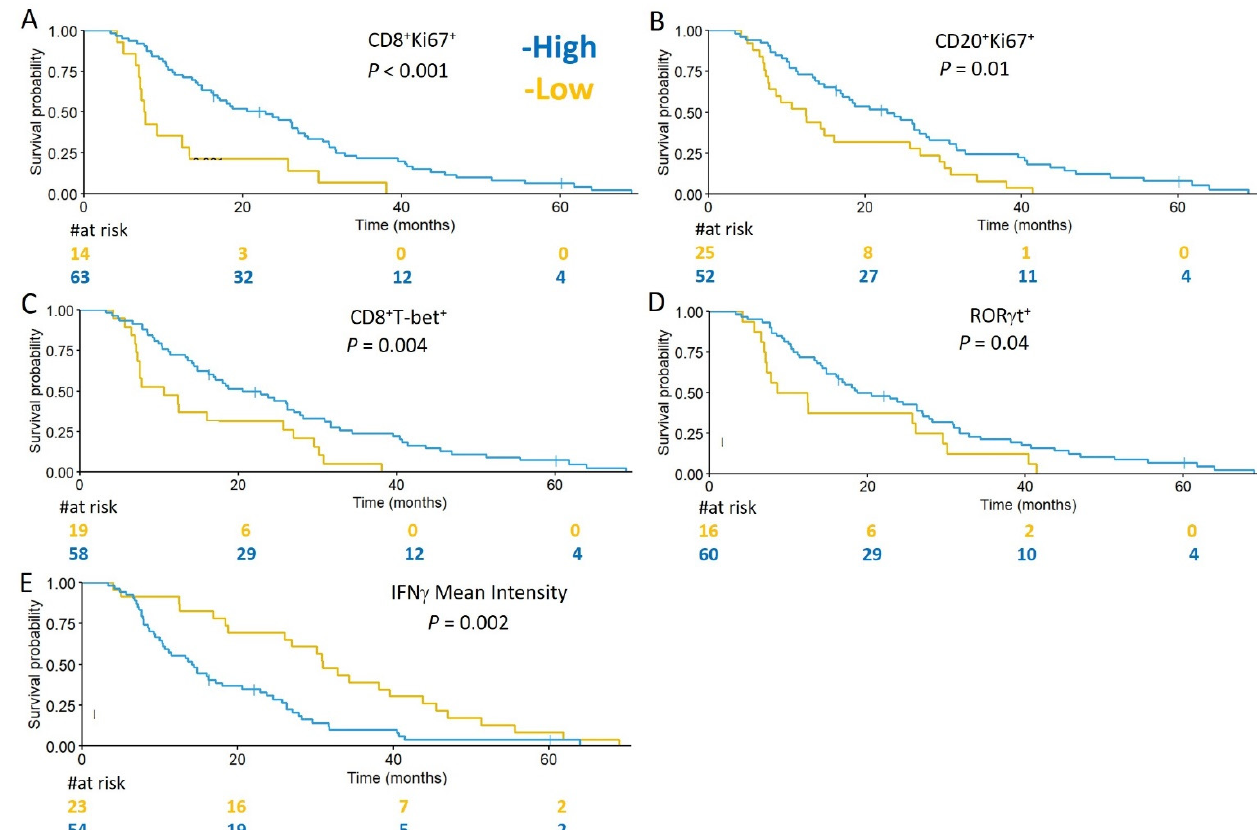
Figure 3. Markers of immune activity are associated with OS in GBM. Kaplan–Meier curves for the indicated immune markers, dichotomized into high (blue) and low (yellow), are shown in ( A – E ). Prolonged OS is associated with tumors containing high densities of: CD8 + Ki67 + cell infiltrates high (22.8 months) vs. low (7.7 months) ( A ); CD20 + Ki67 + cell infiltrates high (22.8 months) vs. low (12.4 months) ( B ); CD8 + Tbet + cell infiltrates high (20.5 months) vs. low (10.6 months) ( C ); and ROR γ t + cell infiltrates high (18.7 months) vs. low (10.5 months) ( D ). Diminished OS was associated with tumors expressing higher mean intensities of IFN γ (30.9 months) vs. low (14.2 months) ( E ).